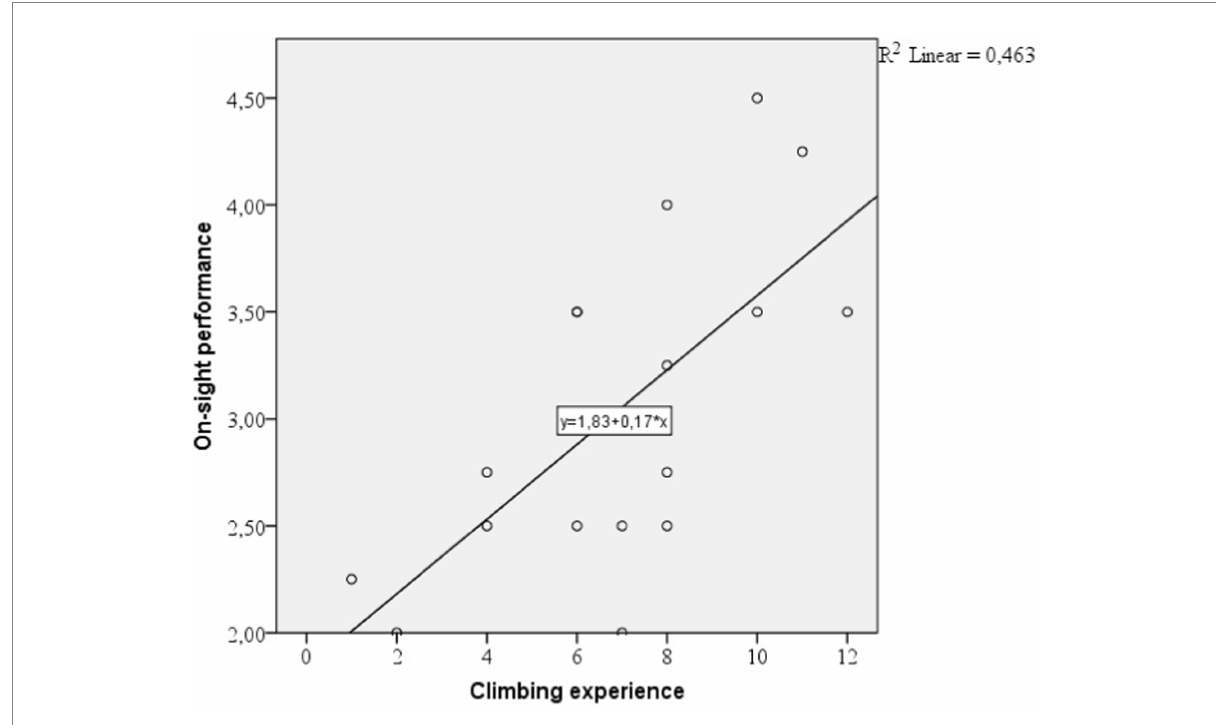
FIGURE 2 Linear regression between climbing experience and on sight performance.